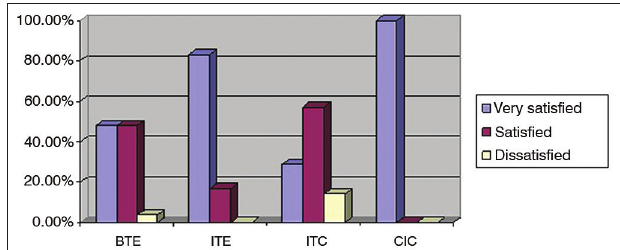
Figure 5. Percent distribution of hearing aid types per level of global satisfaction. BTE: Behind the ear, ITE: In the ear; ITC: In the canal; CIC: Completely in the